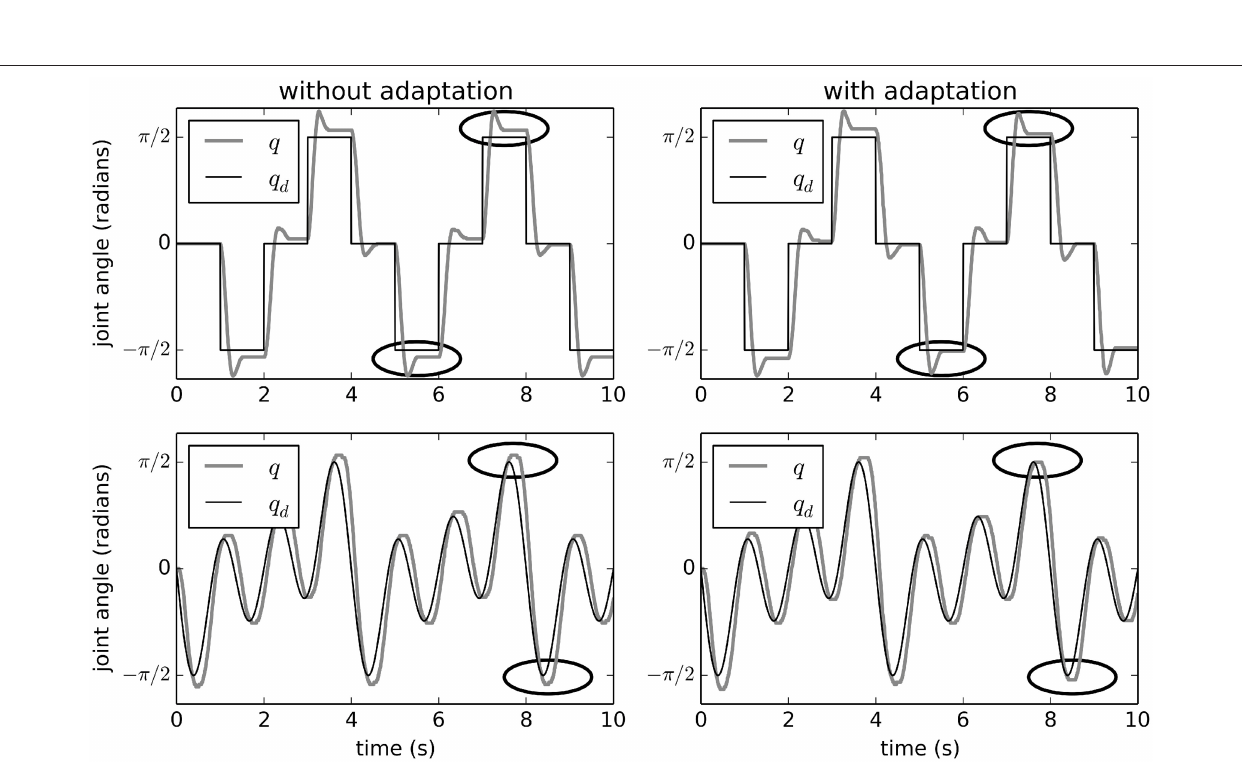
Frontiers in Neuroscience |